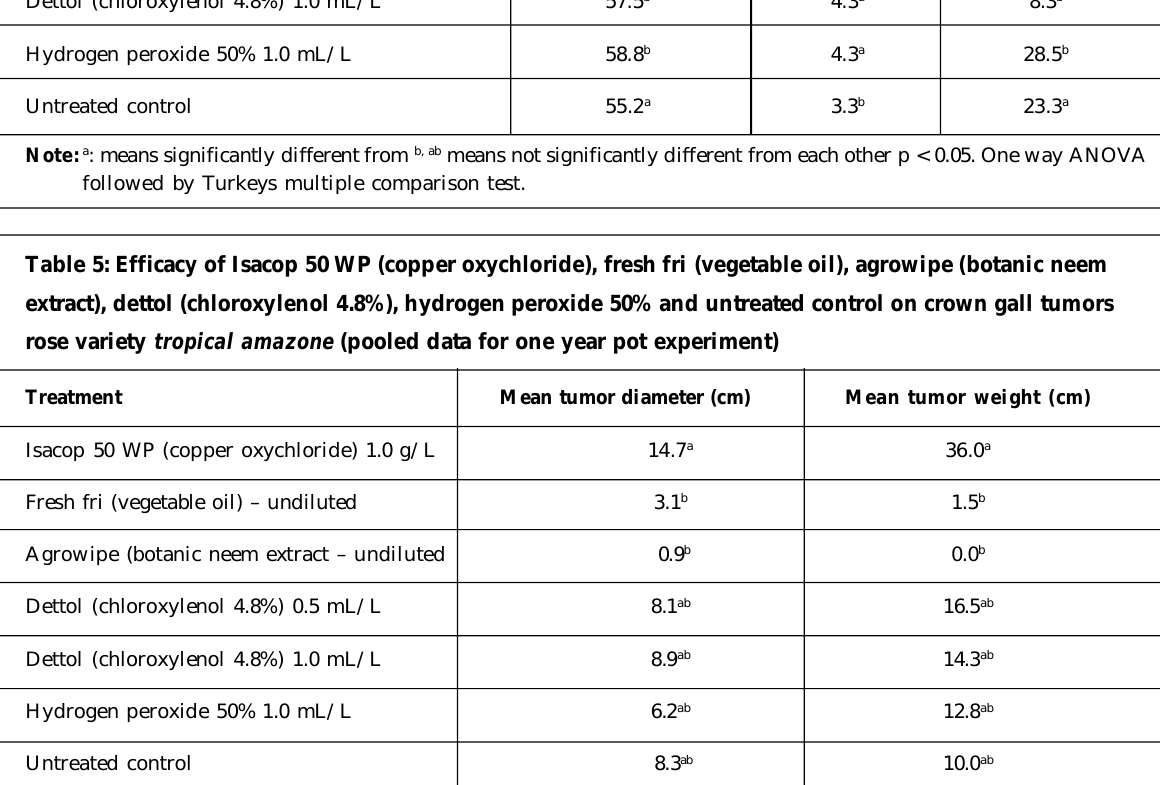
Table 4: Efficacy of Isacop 50 WP (copper oxychloride), fresh fri (vegetable oil), agrowipe (botanic neem extract), dettol (chloroxylenol 4.8%), hydrogen peroxide 50% and untreated control on quality of roses variety tropical amazone (pooled data for one year) Treatment Mean stem length Mean head size Mean stem weight (cm) (cm) (g) Isacop 50 WP (copper oxychloride) 1.0 g/L 54.0 a 3.4 b 23.0 a Fresh fri (vegetable oil) – undiluted 59.0 b 4.1 ab 28.5 b Agrowipe (botanic neem extract – undiluted 59.0 b 4.1 ab 28.3 b Dettol (chloroxylenol 4.8%) 0.5 mL/L 59.0 b Dettol (chloroxylenol 4.8%) 1.0 mL/L